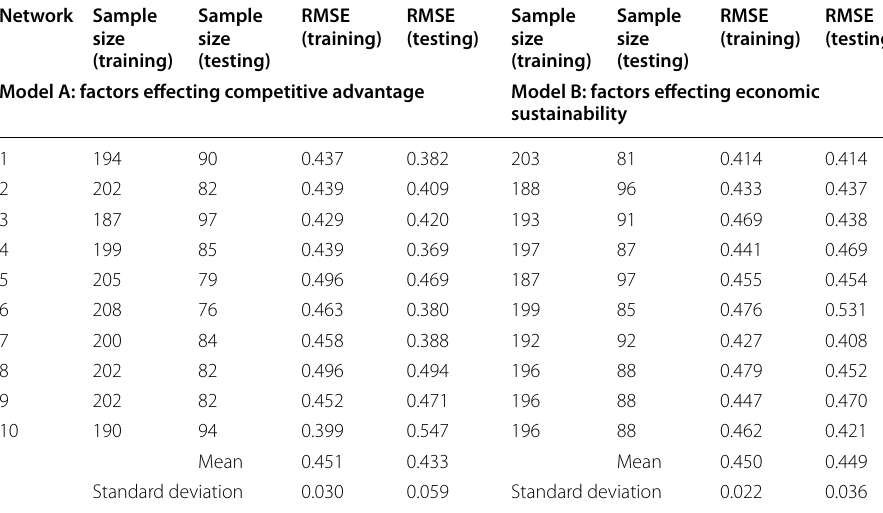
Table 6 RMSE values of artificial neural networks ( N